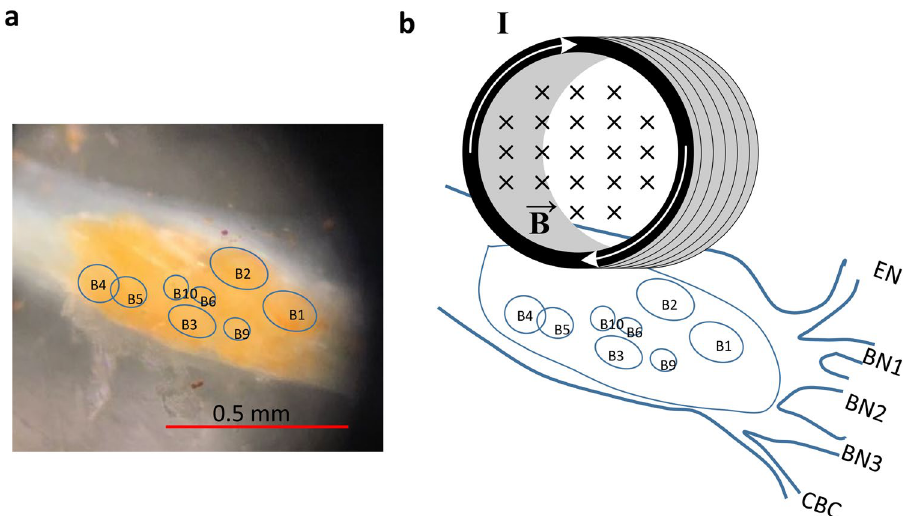
Figure 3. Magnetic stimulation applied to the buccal ganglion of Aplysia . ( a ) The buccal ganglion and the identified neurons. ( b ) An illustration of the buccal ganglion under miniature coil stimulation. A miniature coil was positioned on top of the buccal ganglion for magnetic stimulation (I: electric current inside the coil, B: inward magnetic field generated by the electric current). Locations of interneurons (B4 and B5), motor neurons (B3, B6, B9, and B10), and several other neurons and nerves (EN: esophageal nerve, BN1: buccal nerve I, BN2: buccal nerve II, BN3: buccal nerve III, and CBC: cerebro-buccal connection) were identified in the